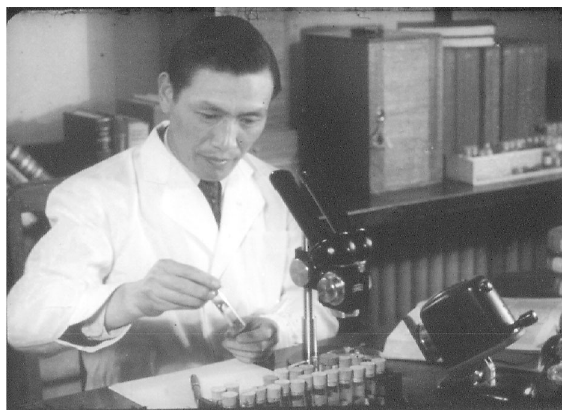
Figure 1. Prof. Hongfu Chu. Working in the laboratory (mid- 1950s).